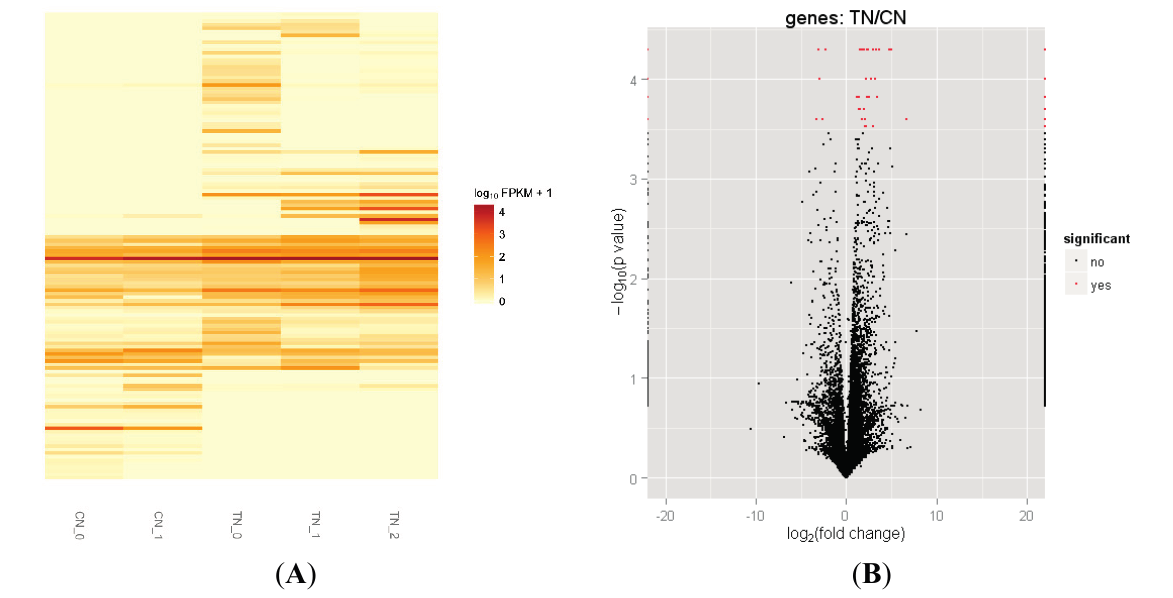
Figure 2. Differentially expressed genes between MSTN propeptide transgenic mice and their littermate control mice. ( A ) A heatmap of FPKM expression values in the five samples. Each row represents a gene ID and the column represents a sample; ( B ) The volcano plots reveal genes that differ significantly between two groups. The black dots represent the expression levels of genes that do not differ and the red dots represent the expression level